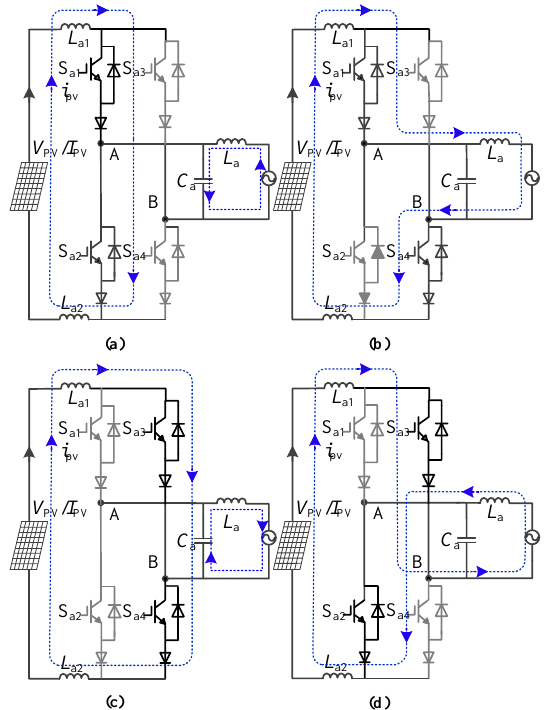
Figure 4. CH4 operating mode: ( a , c ) Sa1 & Sa2 ON or Sa3 & Sa3 ON is mode 0; ( b ) Sa1 & Sa4 ON is mode 1; ( d ) Sa2 & Sa3 ON is mode −1 . A and B are two connection points.